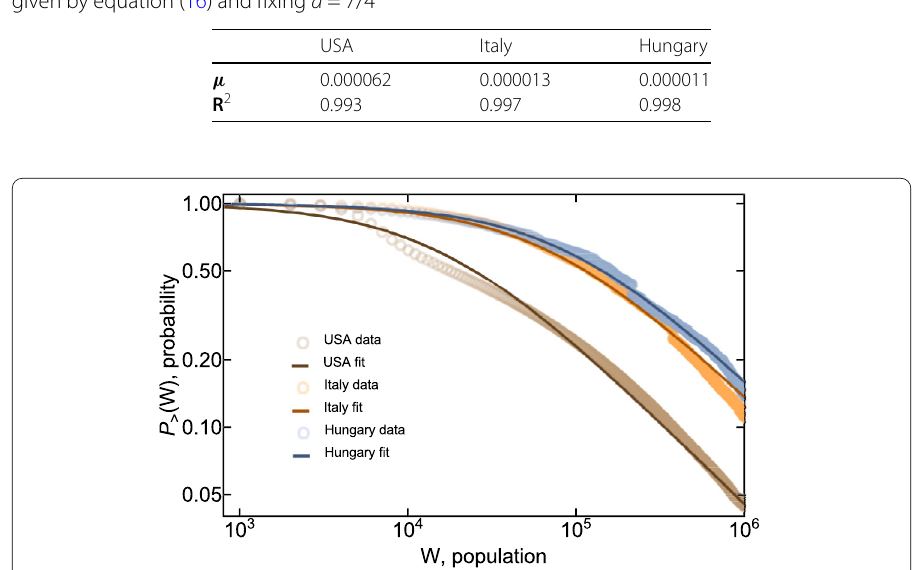
Figure 6 Visual comparison between the FJM model prediction and experimental data for three countries (USA, Italy, Hungary). The faint lines composed of circles show the P > ( W ) experimental data and the simple dark colored lines are the best fits with the FJM model prediction (Eq. (16)). We fixed a = 7/4 and the best fit μ values are given in Table 2